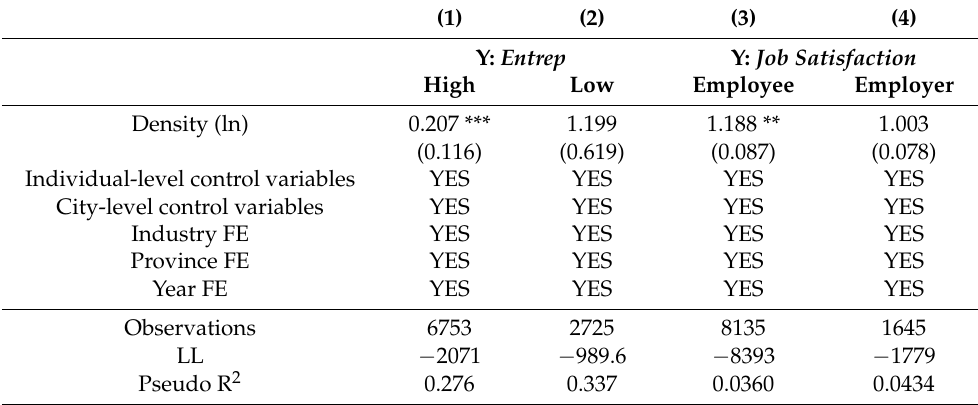
Table 5. Agglomeration economies and entrepreneurship: testing matching